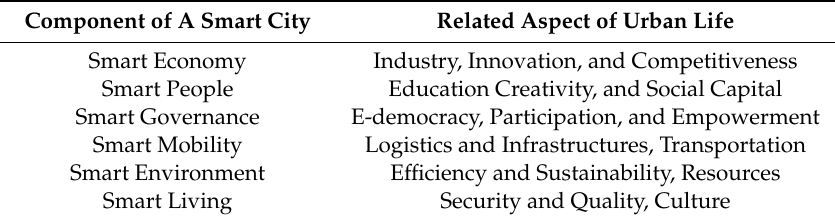
Table 1. Smart city components (adapted from Lombardi et al.